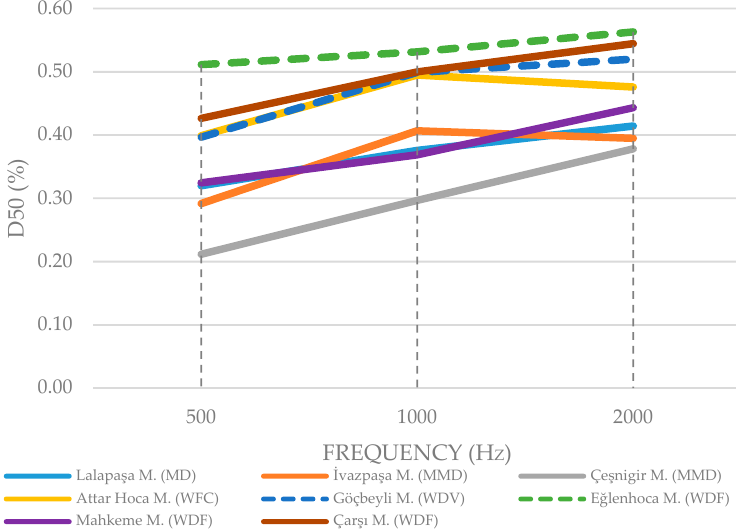
Figure 14. The average values of D50 measured in the eight mosques.